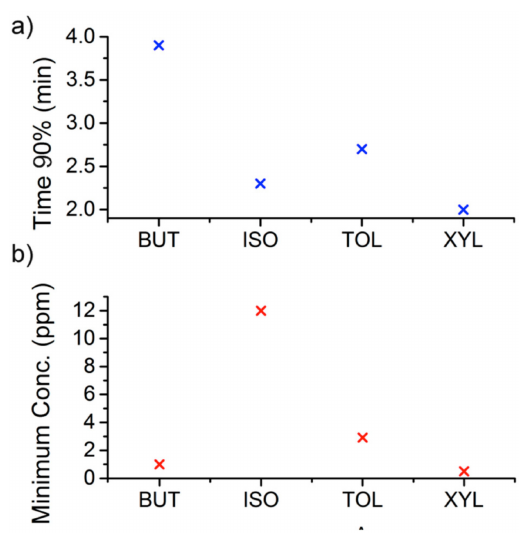
Figure 6. For the tested solvents: ( a ) Signal variation equal to 90% of the complete magnitude of sensor signal; ( b ) Detection limit obtained from minimum concentrations measured.